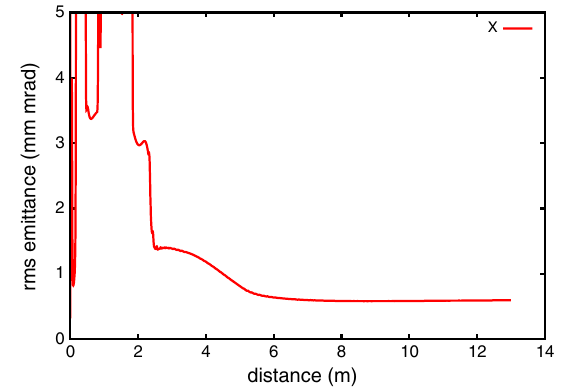
FIG. 4. The current profile (top), slice emittances (middle), and longitudinal phase distribution (bottom) at the exit of the